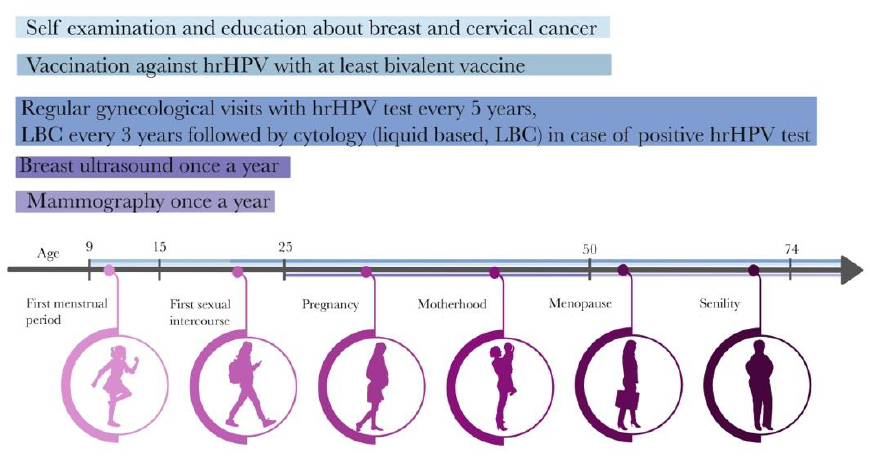
Figure 2. Healthy female timeline.